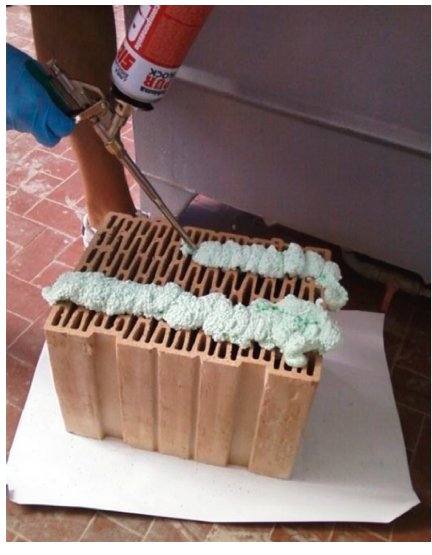
Figure 5: Placement of the